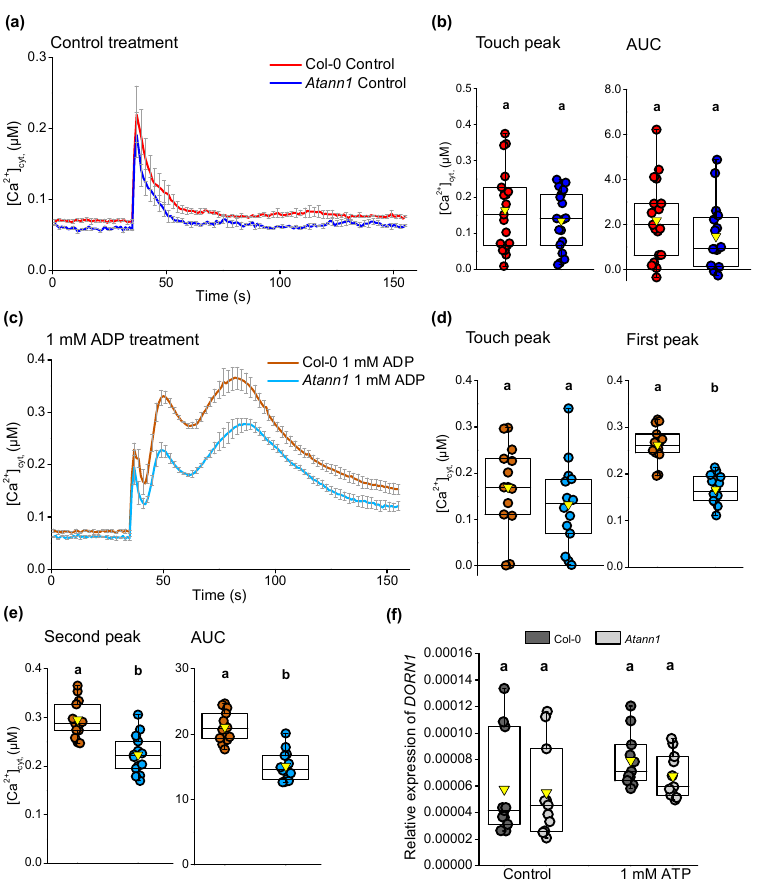
Figure 2. AtANN1 is involved in eADP-induced [Ca 2+ ] cyt elevation in the root. ( a ) Mean (± SEM) time course of [Ca 2+ ] cyt increase by control treatment in three experiments (Col-0 in red, n = 19; Atann1 in blue, n = 18). ( b ) [Ca 2+ ] cyt touch peak values and AUC extracted from the control time course. Middle line of the boxplot represents the median whereas the inverted triangle represents the mean. ( c ) Mean (± SEM) time course of [Ca 2+ ] cyt increase by 1 mM eADP treatment obtained from three exper- iments (Col-0 in brown, n = 14; Atann1 in light blue, n = 14). ( d ) The touch peak and the first peak [Ca 2+ ] cyt values from the 1 mM eADP time course. ( e ) Second peak and the total AUC [Ca 2+ ] cyt values. ( f ) Quantification of AtDORN1 gene expression in Col-0 and Atann1 roots after seven days of growth on control medium or 1 mM eATP-containing medium (Col-0 in black, Atann1 in grey with n = 11 for each genotype and treatment) obtained from three experiments. p -values were obtained from ANOVA with Tukey’s post-hoc test. Different lower-case letters indicate a significant difference be- tween means ( p < 0.05).